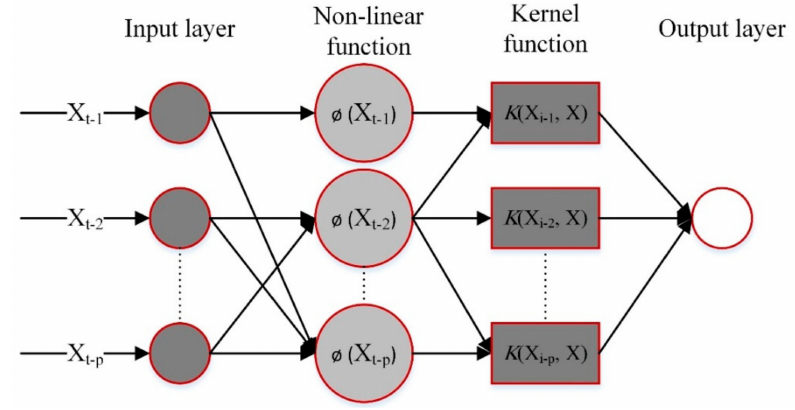
Figure 2. Typical structure of SVM.